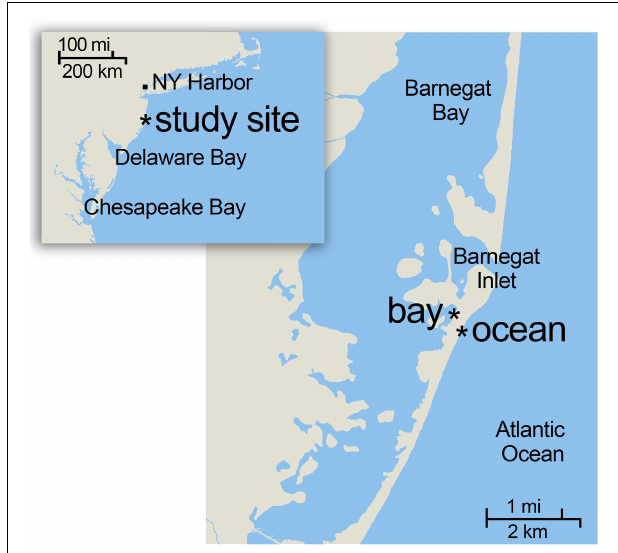
FIGURE 1 | Water collection sites in coastal New